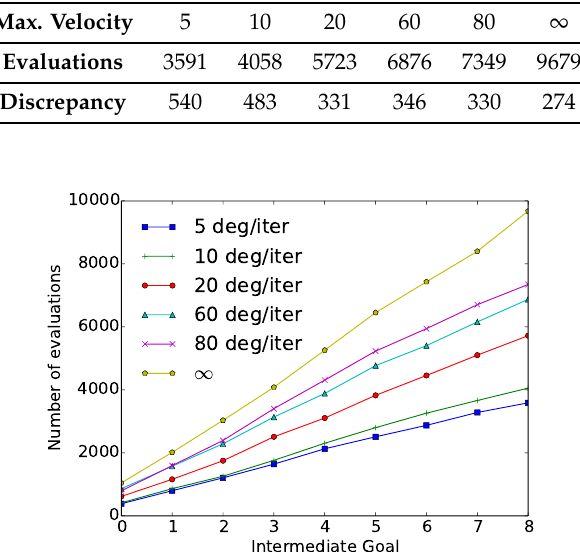
Figure 8. “Wax” velocity constraint experiment results: Number of cumulative evaluations required at each intermediate goal as a function of the velocity constraint (5, 10, 20, 60, 80 and ∞